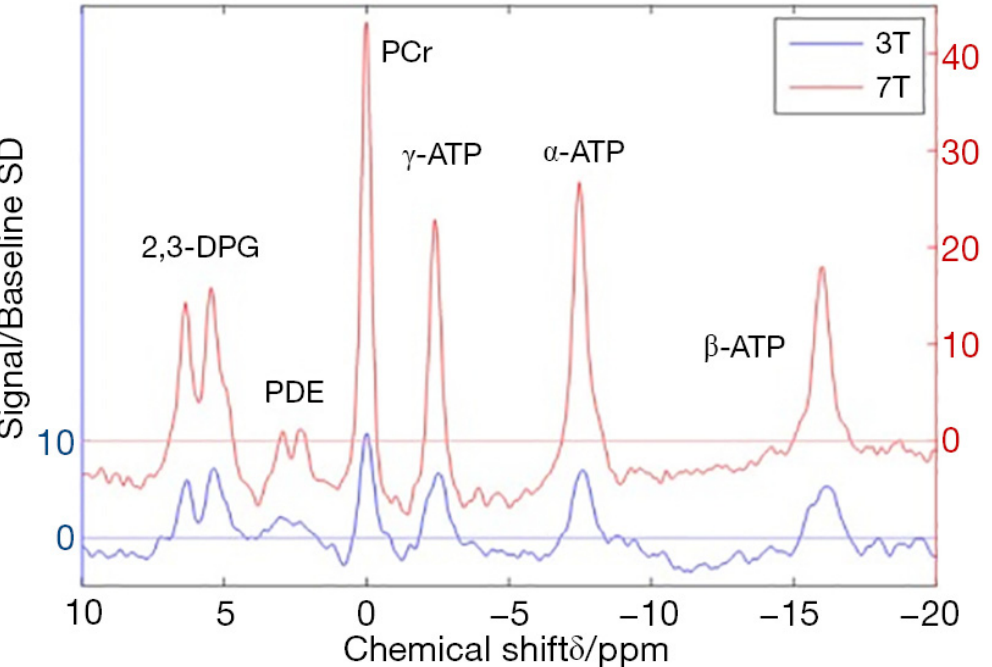
Figure 4. Comparison of cardiac 31 Phosphorus spectra acquired from the same individual at 3 and 7 Tesla field strengths real part of the spectrum from a voxel in the middle of the interventricular septum. The spectra were apodized with an exponential filter (matched to the fitted PCr linewidth), first order phase corrected, and normalized to the resulting baseline noise standard deviation. Higher magnetic field yields higher signal-to-noise ratio (SNR). The SNR is markedly higher for the 7T data. Note that the y-axes are offset for clarity. Reproduced with permission from Rodgers et al. [87] under a Creative Commons Attribution 4.0 International License. SD: standard deviation; 2,3-DPG, 2,3-Diphosphoglycerate; PDE, phosphodiesters; PCr, phosphocreatine; ATP, adenosine triphosphate; ppm, parts per